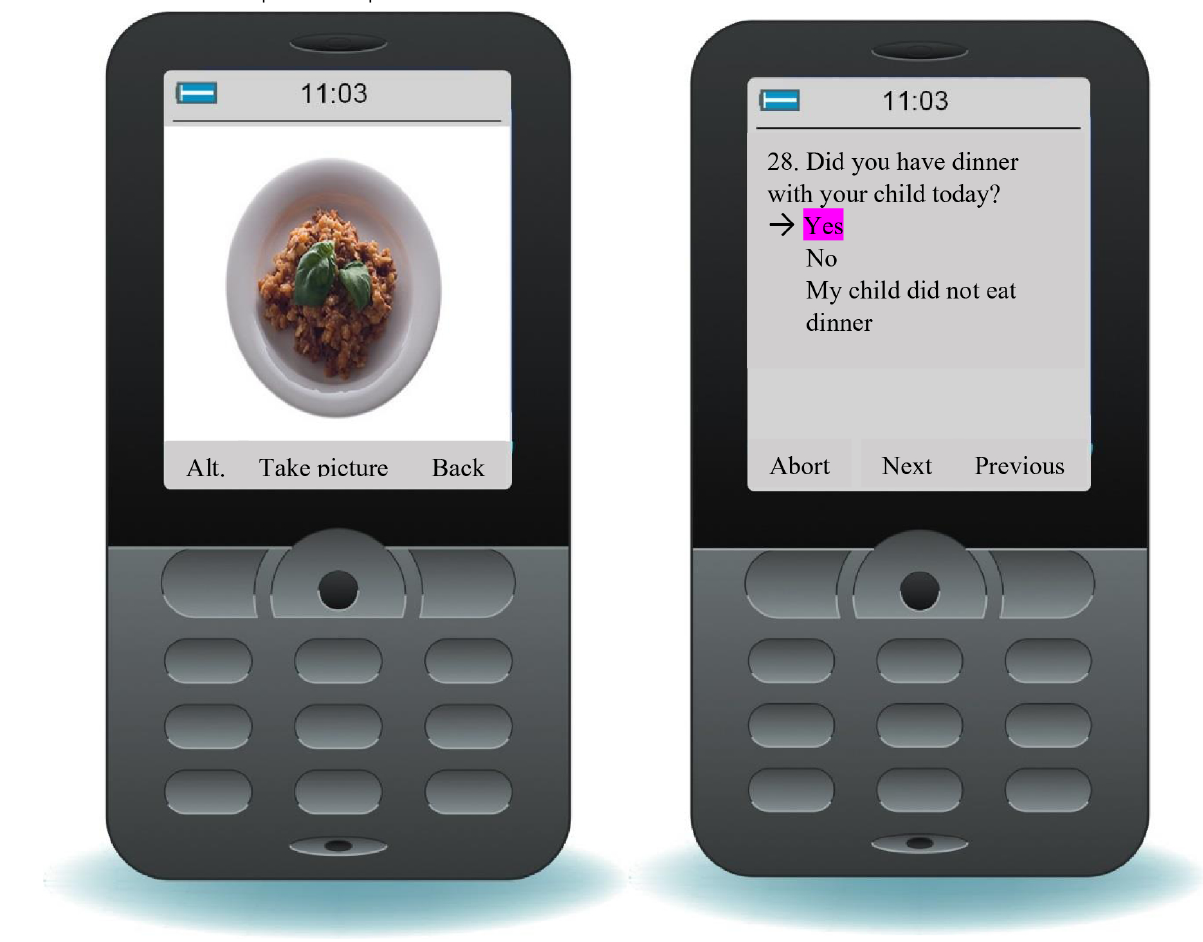
Figure 1. Screenshot of a TECH question and